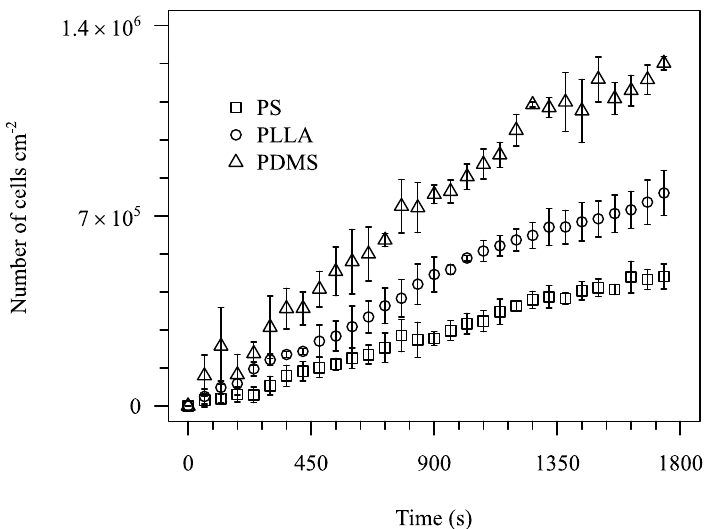
Figure 5. Number of adhered cells per cm 2 for PS, PLLA and PDMS for nominal wall shear stress of 0.02 Pa.